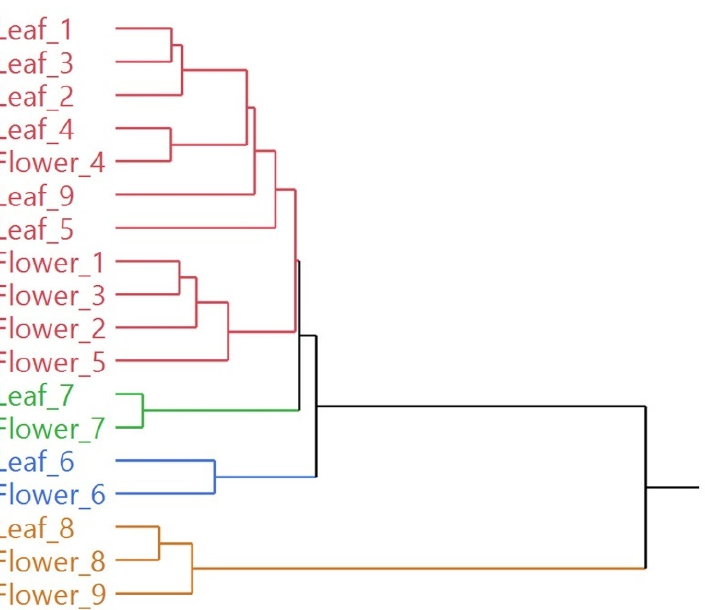
Figure 3. Dendrogram of the hierarchical cluster analysis (HCA) of the complete EO compositions for all samples.